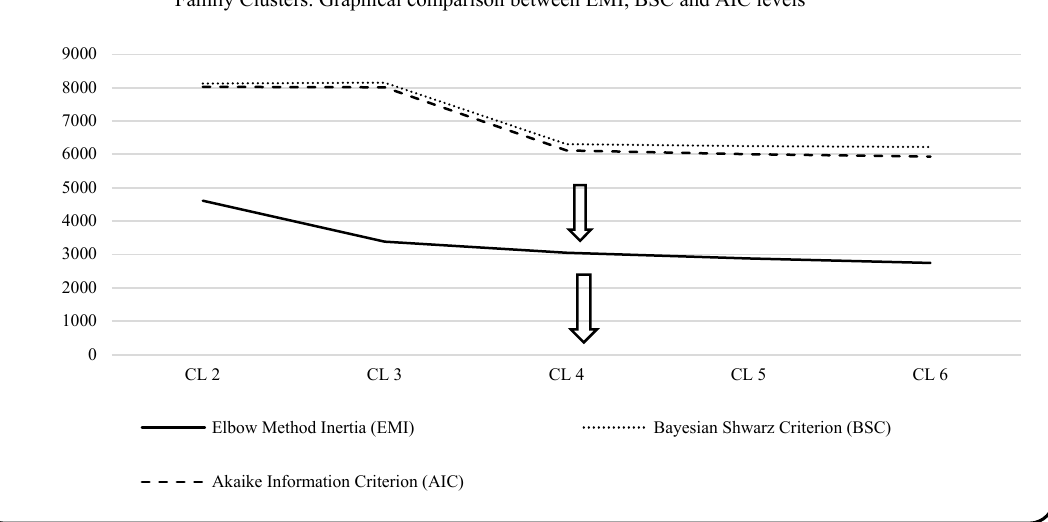
Figure 2. Graphs of decision criteria of an efficient cluster solution.